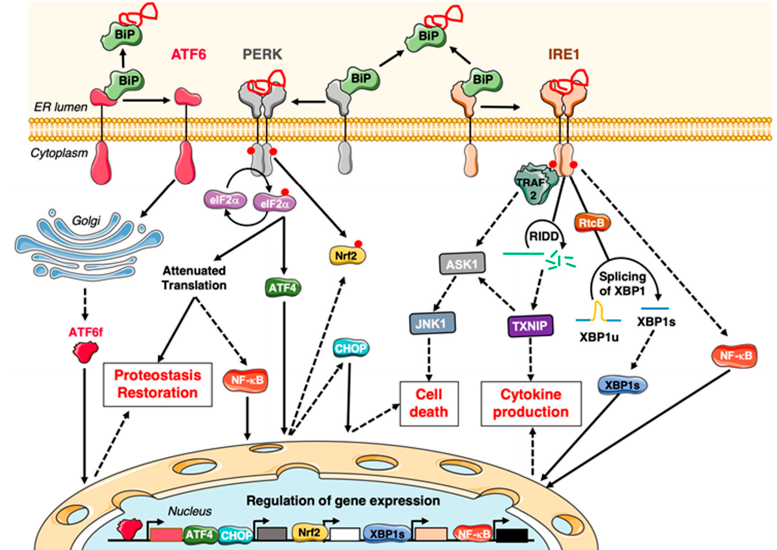
Figure 3. The Unfolded Protein Response (UPR). Each branch and sub-branch of the UPR impacts on multiple cellular outcomes (only some of which are represented, see text). Beyond the relative intensity of activation of each branch, their dynamic of activation also plays a role in controlling cell fate [228].